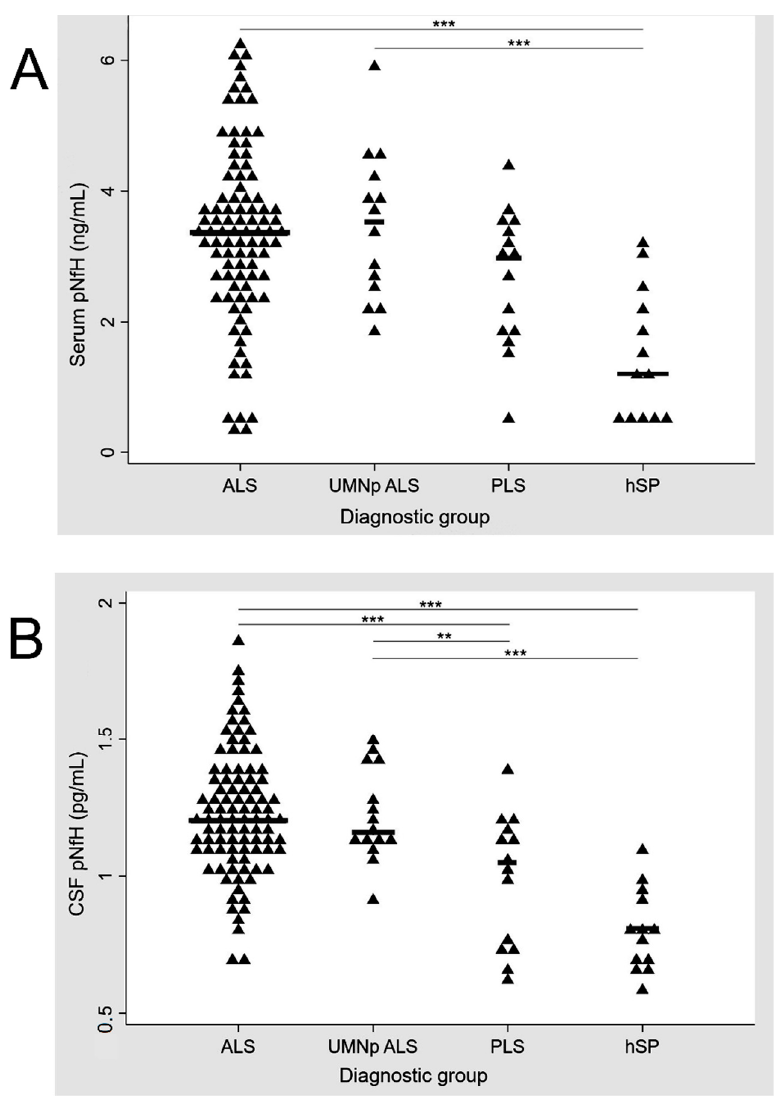
Figure 1. Distribution of pNfH in serum ( A ) and CSF ( B ) across ALS, UMNp ALS, PLS, and hSP. p -values for comparisons between diagnostic groups: *** p < 0.001, ** p = 0.05. Scatter plot of single concentrations (represented by triangles), according to the diagnostic groups. ALS, amyotrophic lateral sclerosis; CSF, cerebrospinal fluid; hSP, hereditary spastic paraparesis; pNfH, phosphorylated neurofilament heavy chain; UMNp-ALS, upper motor neuron predominant-ALS. In serum pNfH, significant differences were observed only between ALS, UMNp and hSP while concentrations of CSF pNfH were significantly different for ALS and PLS, ALS and hSP, UMNp and PLS, and UMNp and